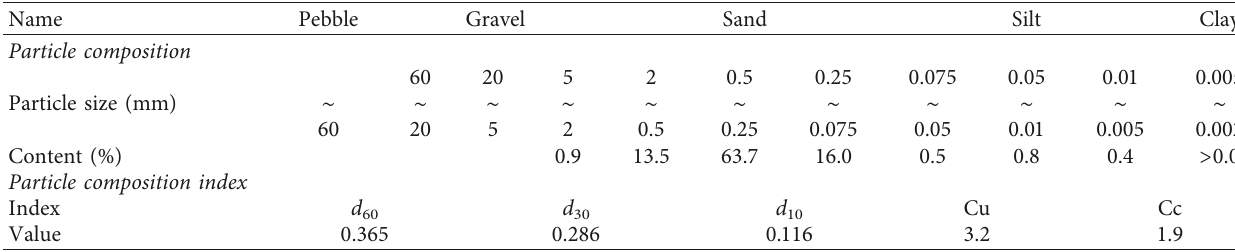
Table 2: Particle composition and related indexes of the backfilled